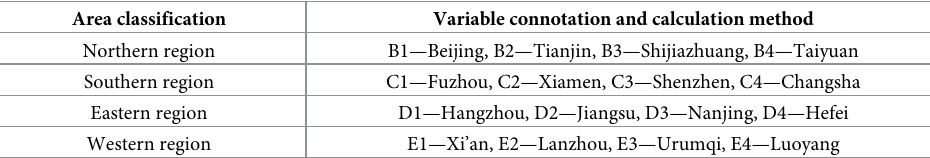
Table 2. Selected city samples of high-tech